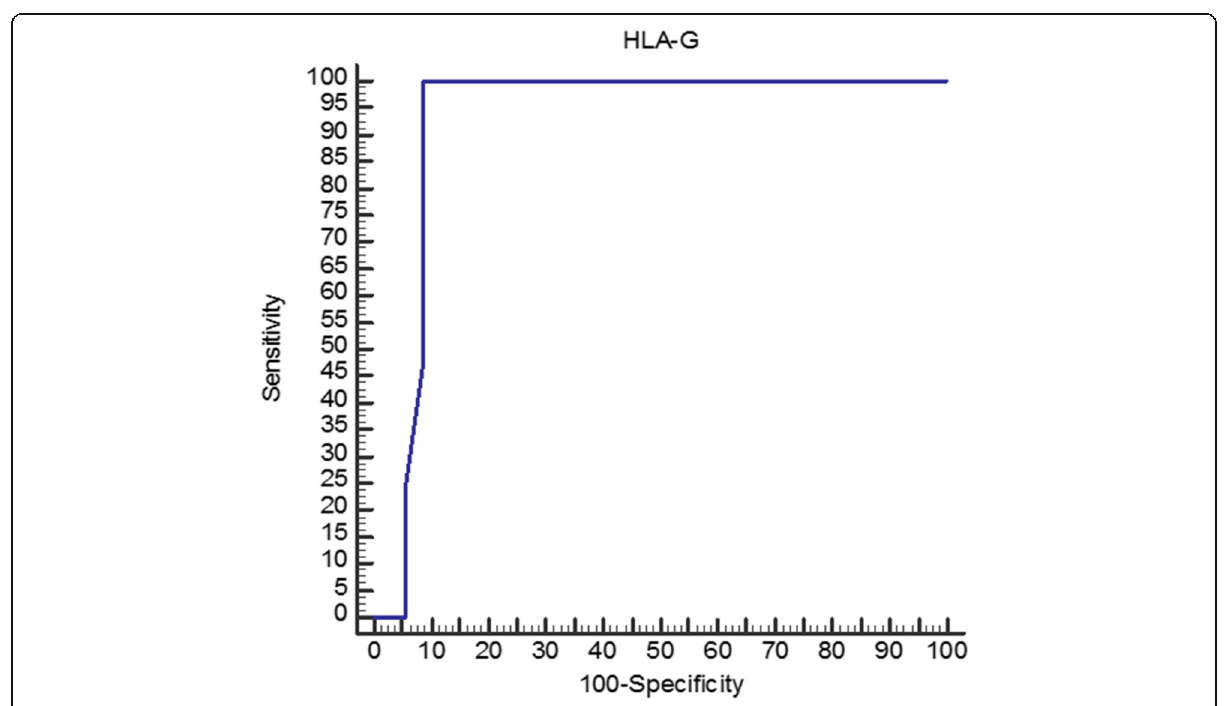
Fig. 2 Diagnostic accuracy of HLA-G in diagnosing